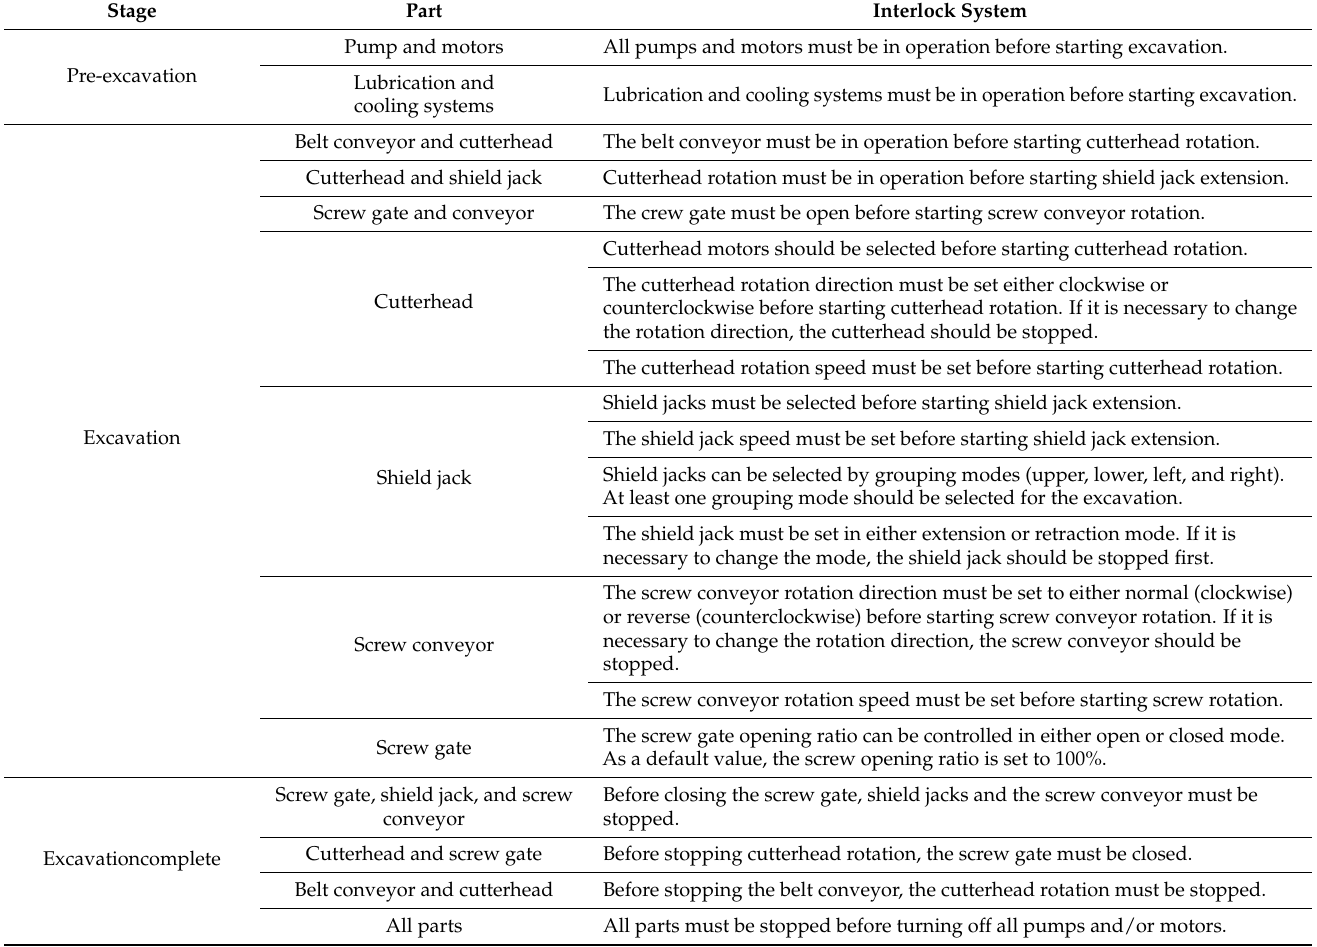
Table 5. Mandatory interlock systems applied in the